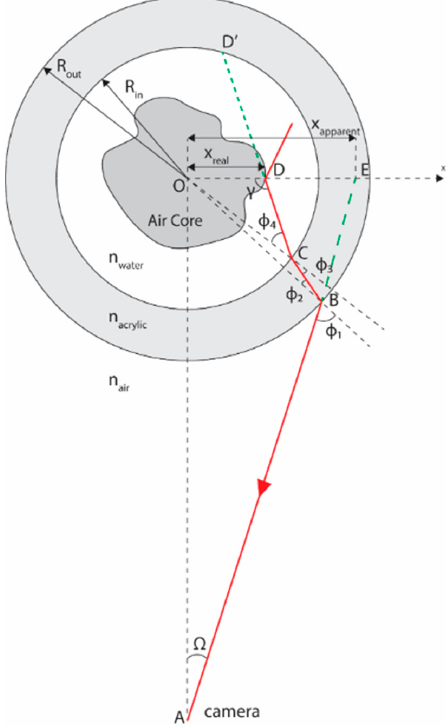
Figure 12. The refraction model is based on light rays reaching the camera. Their red line corresponds to the light ray, and the green lines correspond to extensions of the light rays that are useful for the analysis. The x -axis is placed on top of the focal plane of the camera, and the light ray path is for illustration porpoise only, without taking into account the real scales of the setup or the actual path of the reflected light ray.